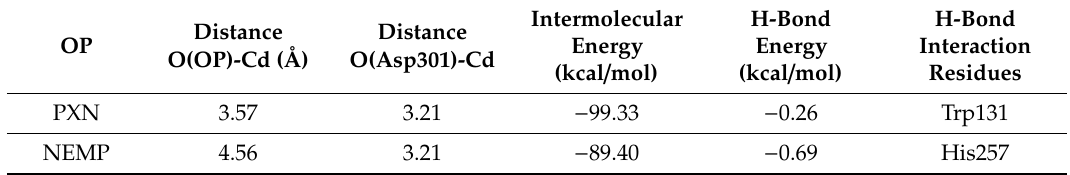
Table 1. Docking results for the organophosphorus (OP).